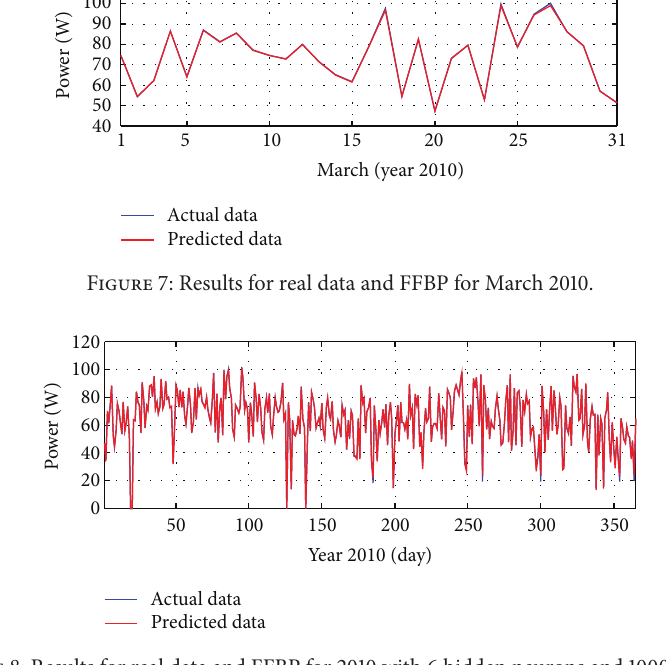
low. According to Figure 11 the best validation performance is 4.4514 × 10 −7 at epoch